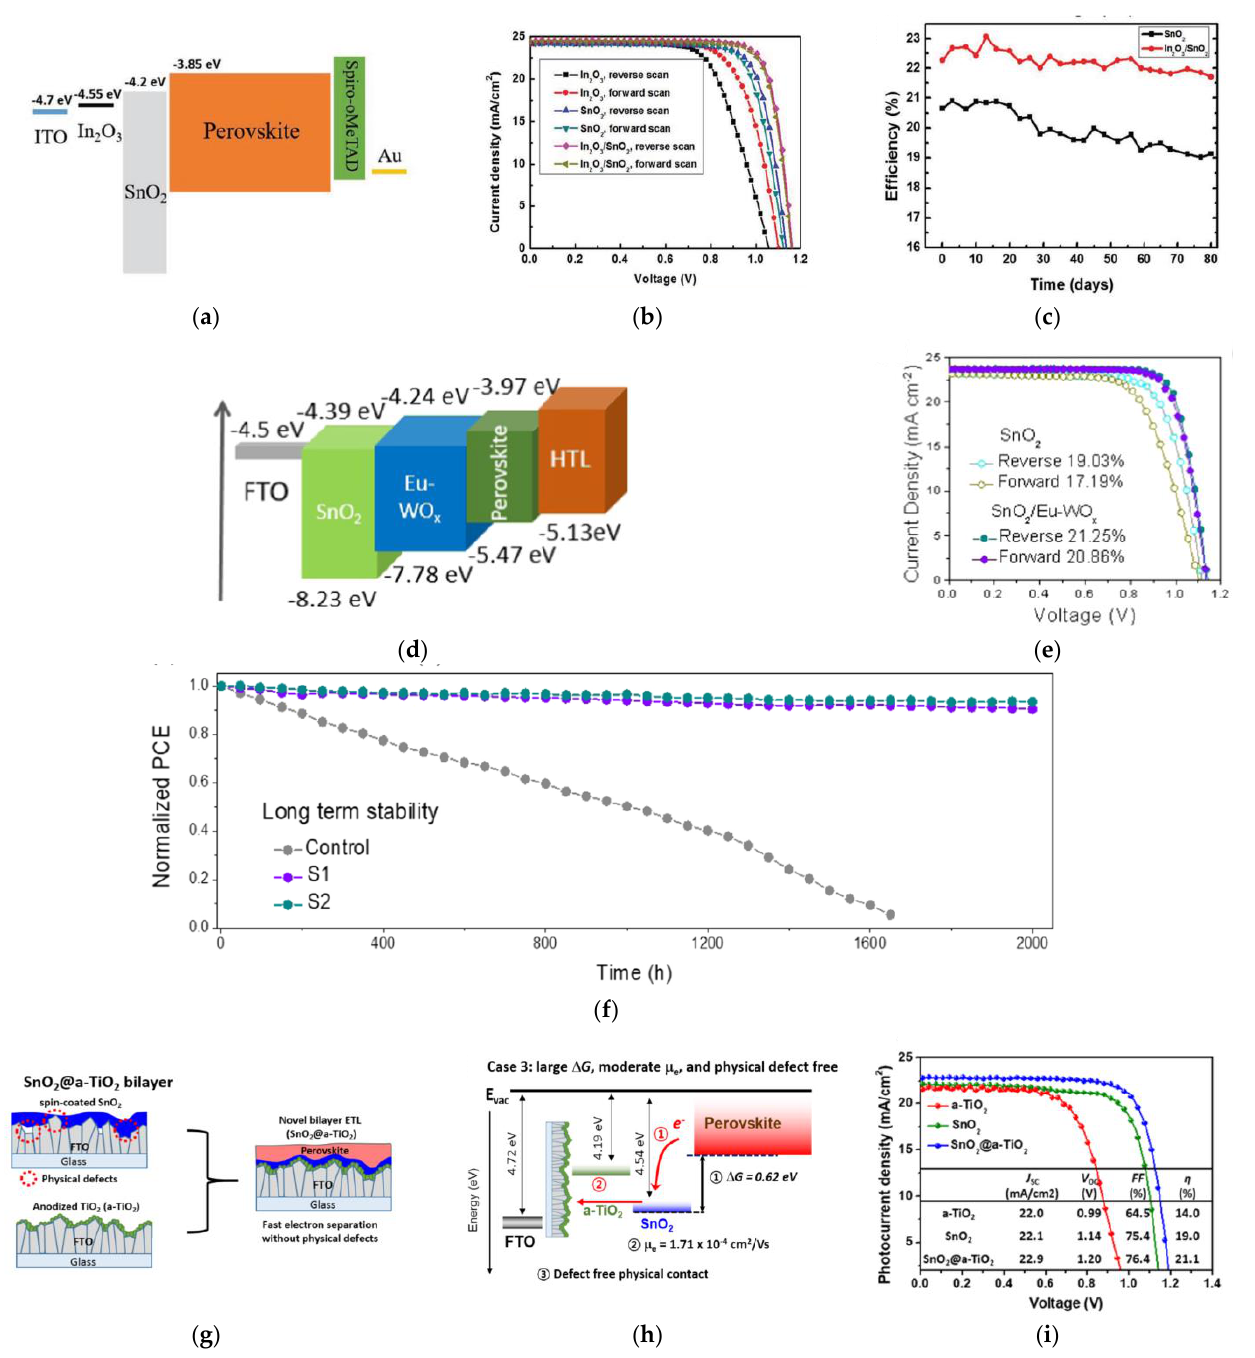
Figure 2. ( a ) Energy-band diagram of PSC based on In 2 O 3 /SnO 2 . ( b ) Illuminated J - V curves under 1 SUN for forward- and reverse-voltage scans of In 2 O 3 , SnO 2 , and In 2 O 3 /SnO 2 -based PSC devices. ( c ) Long-term stability measurements of devices with different ETLs. Reproduced from [31] with permission from Wiley, 2020 ( d ) Energy-band diagram of each layer in PSCs. ( e ) Illuminated J - V curves under 1 SUN under reverse- and forward-voltage scanning of PSC devices with different ETLs. ( f ) Long-term stability measurements of PSCs with different ETLs in the ambient. Reproduced from [32] with permission from Elsevier, 2021. ( g ) Schematic illustration of bilayered TiO 2 /SnO 2 ETL. ( h ) Illustration of TiO 2 /SnO 2 ETLs with large change in free energy ( ∆ G ) and moderate electron mobility ( µ e ). ( i ) Illuminated J - V curves under 1 SUN for various ETLs. Reproduced from [33] with permission from ACS Publications,